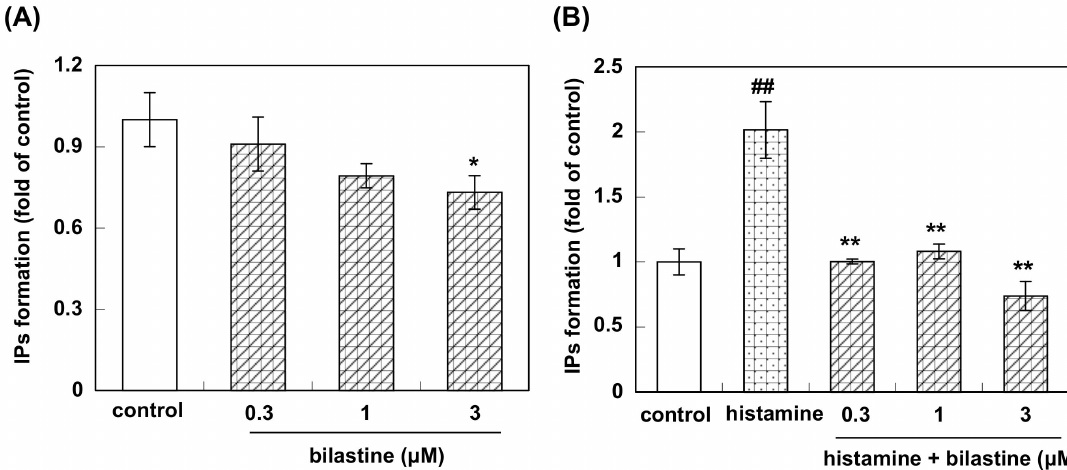
Figure 4. E ff ect of bilastine on accumulation of IPs in HeLa cells. ( A ) Dose–response study; HeLa cells were incubated with or without bilastine (0.3 µ M to 3 µ M) for 2.5 h. Then accumulation of IPs was determined as described in the Material and methods. Data are expressed as means ± SEM ( n = 8 for control, n = 9 for 3 µ M bilastine, and n = 6 for 0.3 and 1 µ M bilastine). * p < 0.05 vs. control. In ( B ), HeLa cells were stimulated with 100 µ M histamine for 2.5 h with or without bilastine (0.3 µ M to 3 µ M). Data are expressed as means ± SEM ( n = 8 for control, n = 9 for 3 µ M bilastine, n = 6 for 1 µ M bilastine, and n = 5 for 0.3 µ M bilastine). ##, p < 0.01 vs. control; **, p < 0.01; *, p < 0.05 vs.